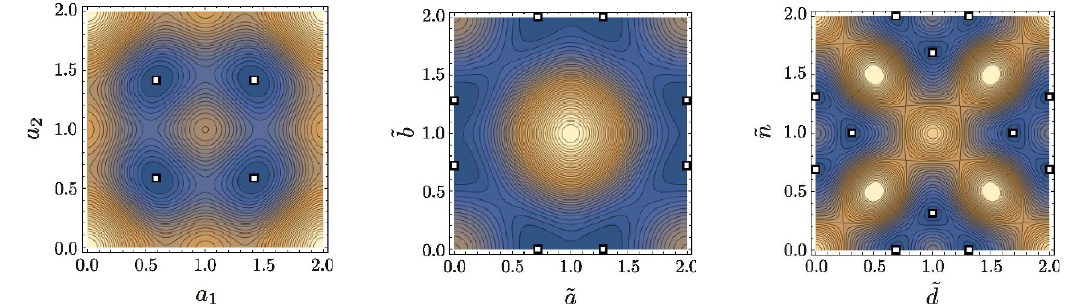
Figure 1 . The color contour plots of the one-loop e(cid:11)ective potentials as functions of the parametrized zero modes of A 5 in SU(7) model with N 7 = (0 ; 0 ; 0 ; 0 ; 2 ; 0 ; 0 ; 0) (left), SO(10) model with N 10 = (0 ; 1 ; 0 ; 0 ; 1 ; 0) (center), and E 6 model with N E = (0 ; 4 ; 1 ; 2) (right). From light orange 6 region to dark blue region, values of the potential decrease. In each (cid:12)gure, we show positions of the global minima of the potential by the square